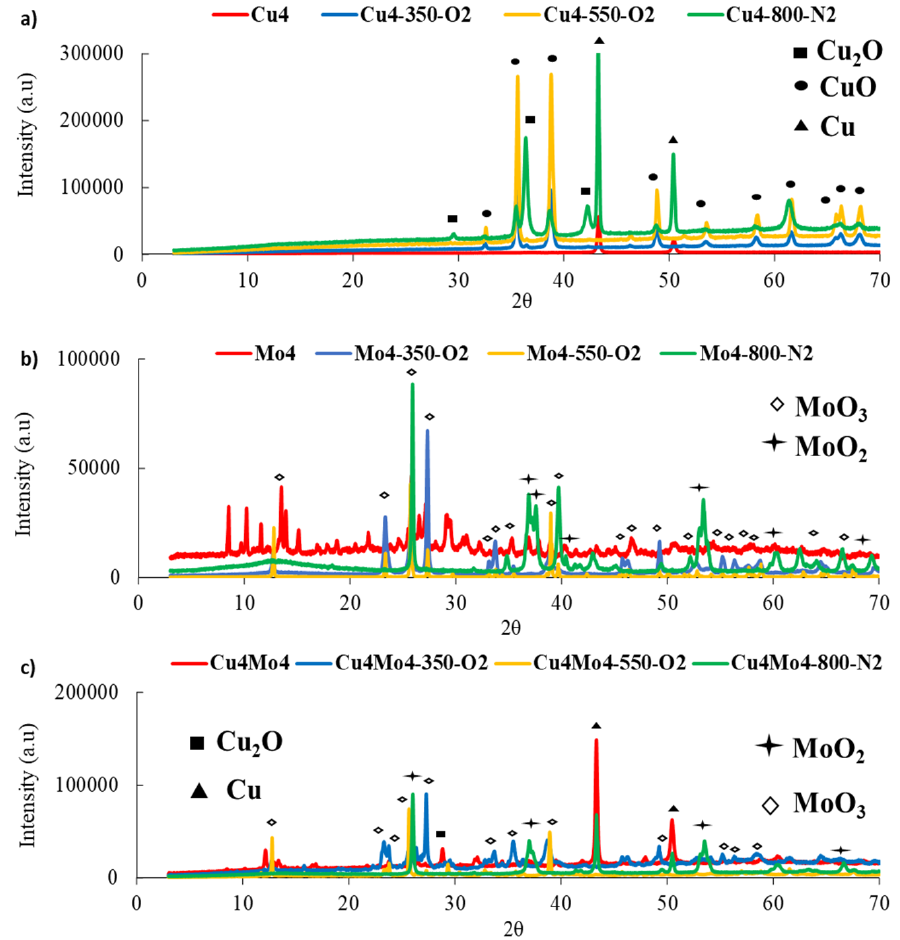
Figure 4. XRD patterns of the prepared catalysts: ( a ) Cu series; ( b ) Mo series; ( c ) CuMo series. Table 3. Summary of the main crystalline parameters obtained from XRD.